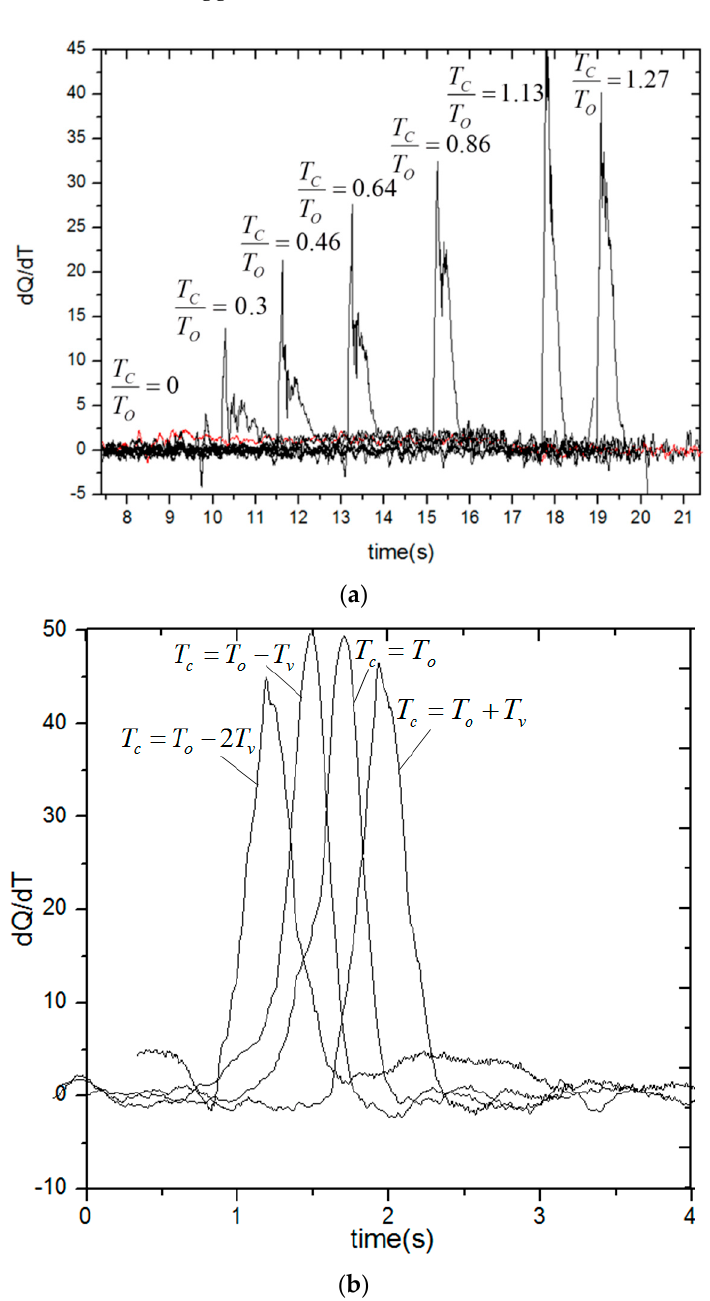
Figure 10. Differential flow for different startup periods; ( a ) flow change rate ( dQ/dT ) for different Figure 10. Di ff erential flow for di ff erent startup periods; ( a ) flow change rate ( dQ / dT ) for di ff erent startup periods; ( b ) flow change rate ( dQ/dT ) curve when T c is in the vicinity of 1.13 T o . startup periods; ( b ) flow change rate ( dQ / dT ) curve when T c is in the vicinity of 1.13 T o